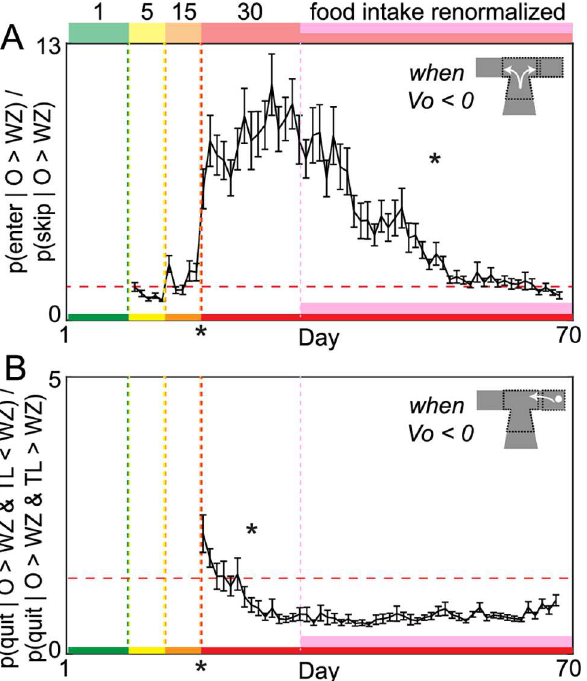
Fig 4. Development of separate intermediate wait zone and long-term offer zone efficient decision-making strategies. (A) Offer zone inefficiency ratio. V O = WZ–O. Probability of entering negatively valued offers relative to the probability of skipping negatively valued offers. Horizontal dashed line indicates equivalent 1:1 ratio of entering versus skipping negatively valued offers. (B) Wait zone inefficiency ratio. V L = WZ–TL. Probability of quitting negatively valued offers when V L was positive relative to when V L was still negative. Horizontal dashed line indicates equivalent 1:1 ratio of quitting inefficiently versus efficiently. Data are presented as the cohort’s ( N = 31) daily means ( ± 1 SE) across the entire experiment. Color code on the x-axis reflects the stages of training (offer cost ranges denoted from 1 to the number on the top of panel A). Vertical dashed lines (except pink) represent block transitions. (cid:3) on the x- axis indicates ratio significantly greater than 1:1 immediately following the 1–30 s block transition; otherwise, (cid:3) indicates gradual significant changes within the 1–30 s block during either the early 2 wk adaptation period or late pink epoch. Data available as a supplemental file. O, offer cost; TL, countdown time left; V L , value of time left in countdown at the moment of quitting; V O , offer value; WZ, wait zone threshold.